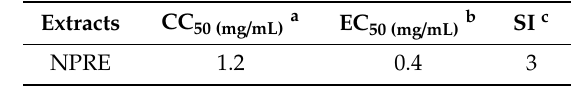
Figure 1. Cell viability of Vero cells treated with increasing concentration of polyphenol-rich extracts from natural shelled pistachios kernels (NPRE). The cell proliferation index (%) was calculated by means of cellular ATP level measured after 72 h treatment. The values were expressed as percentages of treated vs. control cells (DMSO). Each value is the mean ± standard deviation (SD) of three experiments. Table 1. Selectivity index (SI), cytotoxicity (CC 50 ), and antiviral activity (EC 50 ) of polyphenol-rich extracts from natural shelled pistachios kernels (NPRE).